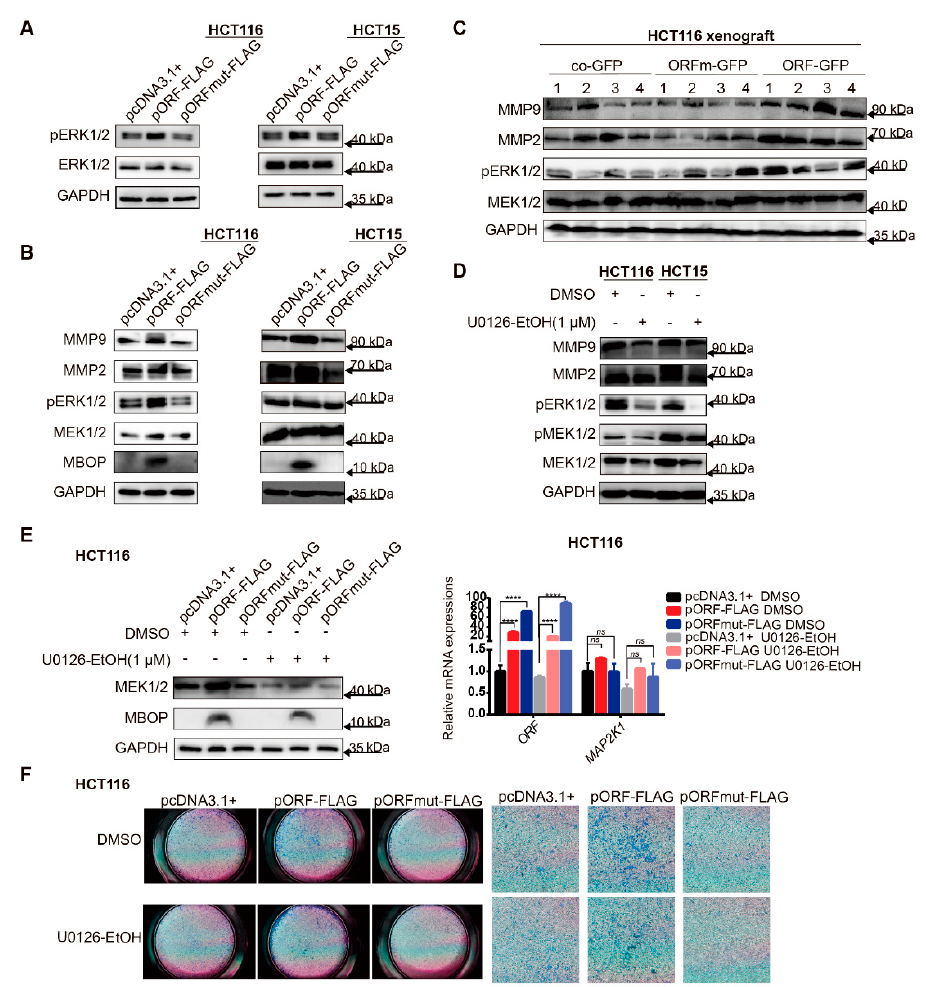
Figure 5. The MBOP/MEK1/pERK/MMP2/MMP9 axis in CRC. ( A ) MBOP substantially promoted the pERK1/2 in HCT116 and HCT15, but the total ERK expression did not show significant differ- ences.